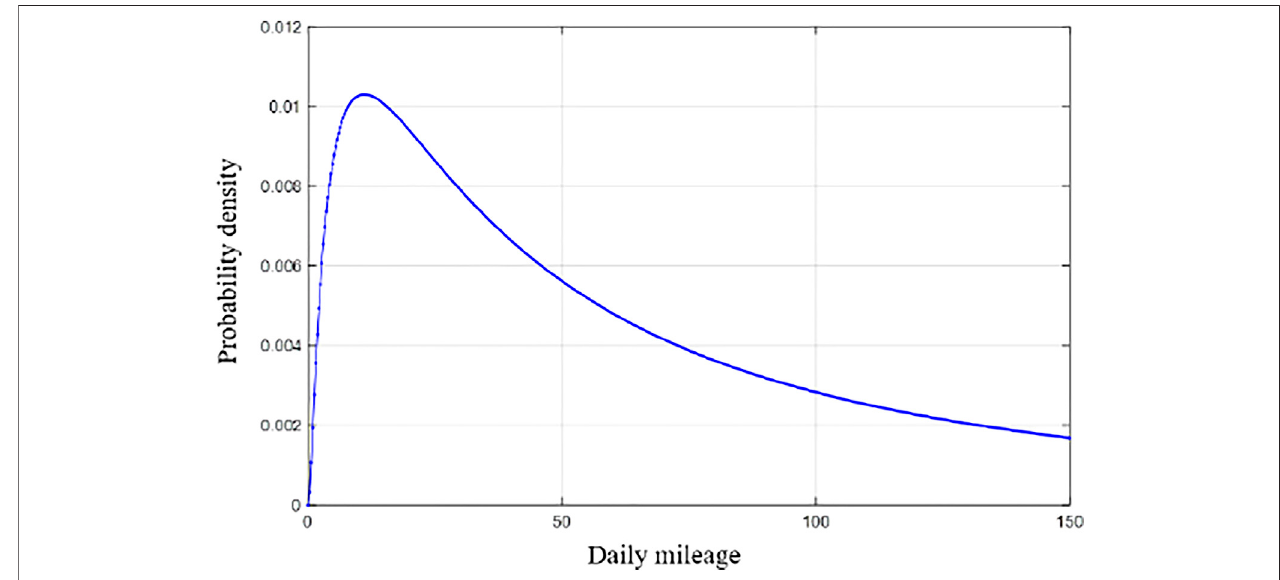
FIGURE 3 | Probability distribution of daily mileage of